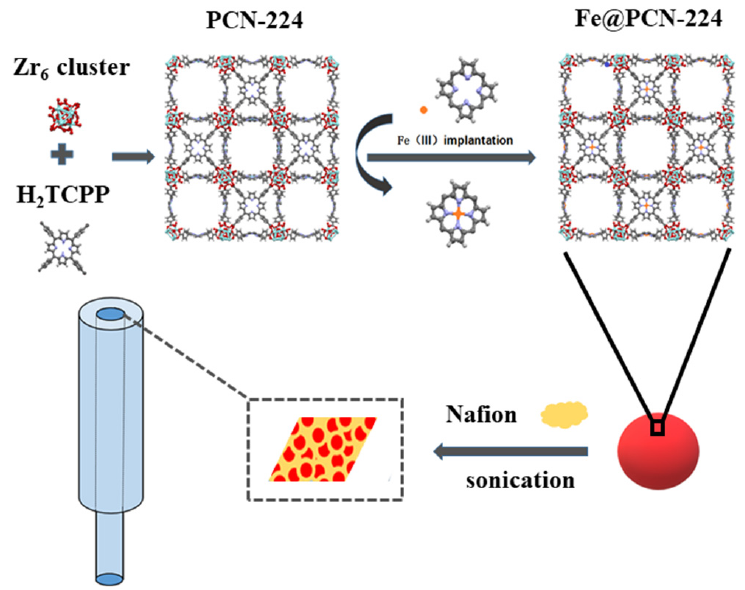
Figure 1. Schematic illustration for the fabrication of Fe@PCN-224/Nafion/glassy carbon electrode (GCE).